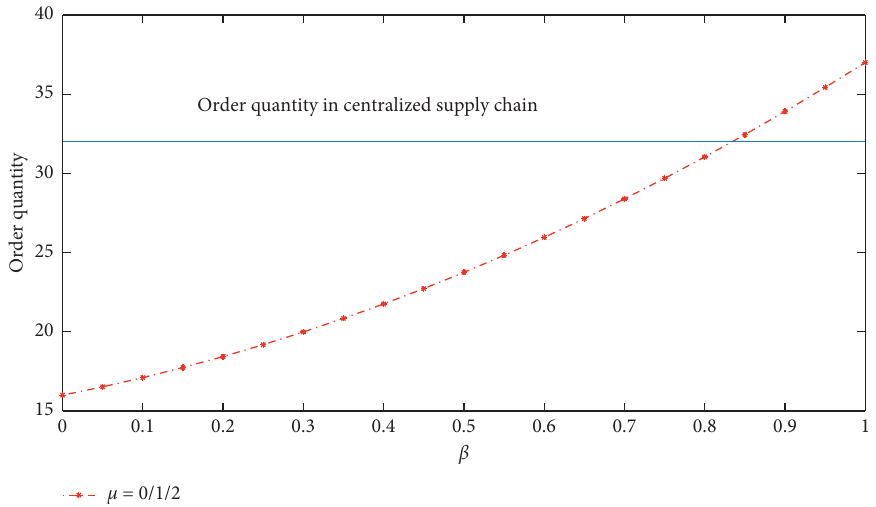
Figure 1: The effect of the cognitive biases on optimal order